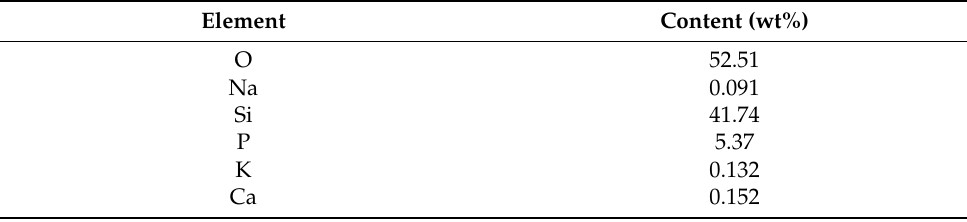
Table 4. EDS elemental composition of purified silica after cleaning with DI water at 60 ◦ C for 3